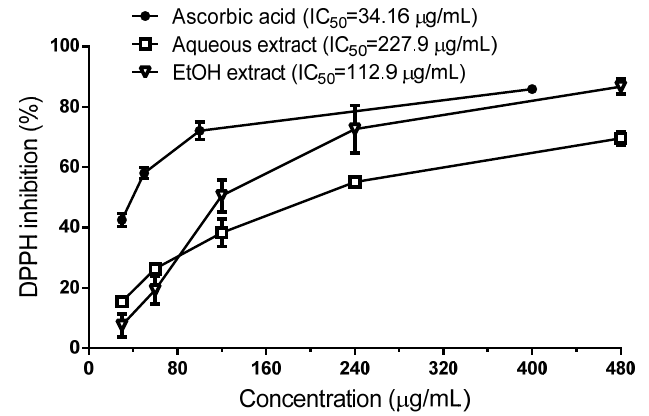
Figure 2. Quenching of DPPH radicals by aqueous and ethanolic extracts from the leaves of R. echinus . Data are expressed as mean ± SEM of n = 4 independent experiments.